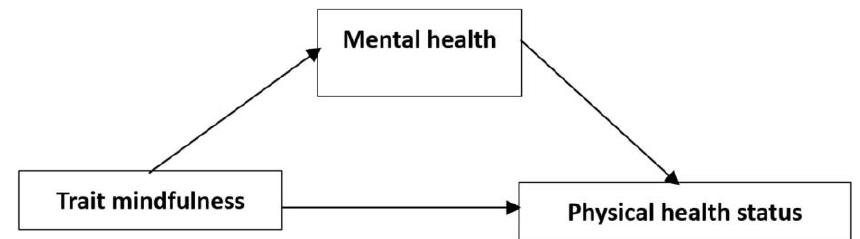
Figure 1. The mediation model of trait mindfulness and physical health.